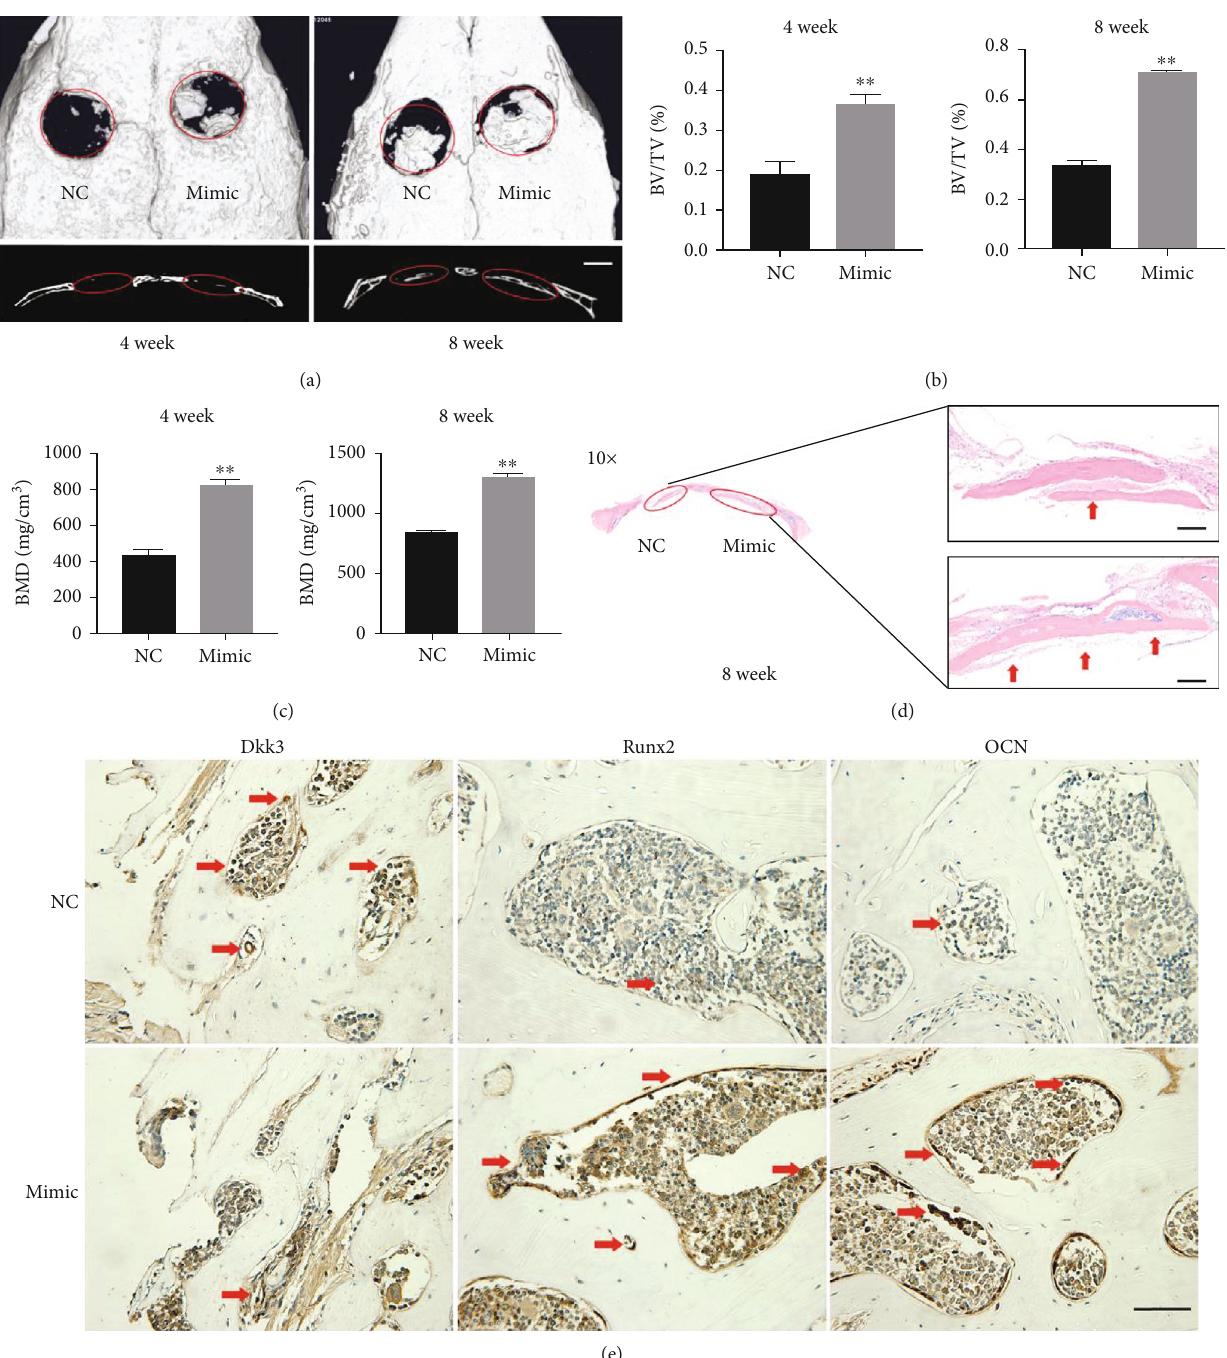
Figure 4: miR-129-5p enhanced bone regeneration in a mouse model of calvaria defect. BMSCs transduced withlentivirus containing miR-129-5p mimic or control miRNA (NC) were loaded on matrigel sca ff olds, respectively, and then implanted into the defect of murine calvarium. Mice were sacri fi ced at week 4 and week 8 after implantation, and then, skull samples were collected for analyses. (a) Image with three-dimensional reconstruction (coronal and sagittal sections) from Micro-CT revealed di ff erent regeneration e ff ects. Quantitative analysis of the 3D images, including new bone volume relative to tissue volume (BV/TV) (b) and the bone mineral density (BMD) (c), was shown. (d) Representative image of H&E staining (red arrow represented bone-like structures). (e) Immunohistochemical assessment of Dkk3, Runx2, and OCN in the NC group and the miR-129-5p mimic group (red arrow represented the positive cells). ∗∗ p < 0 : 01